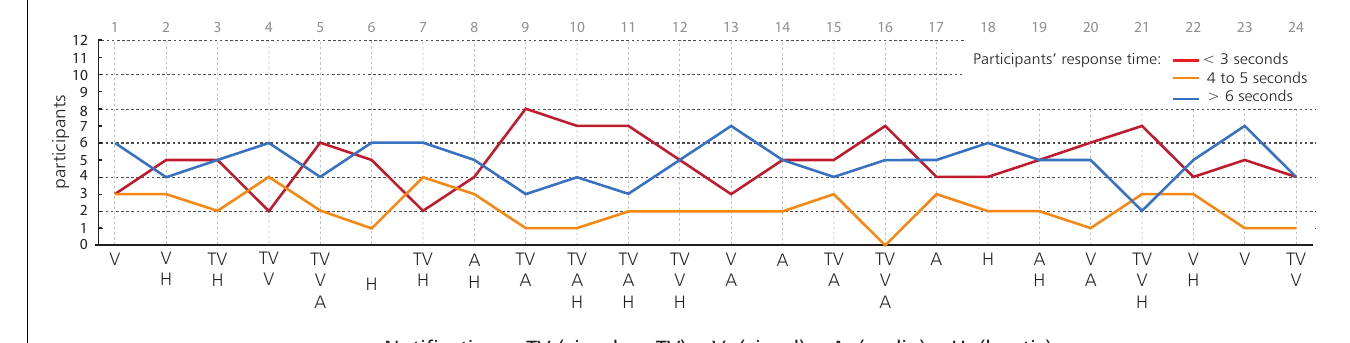
Figure 2 - Participants response time to notifications